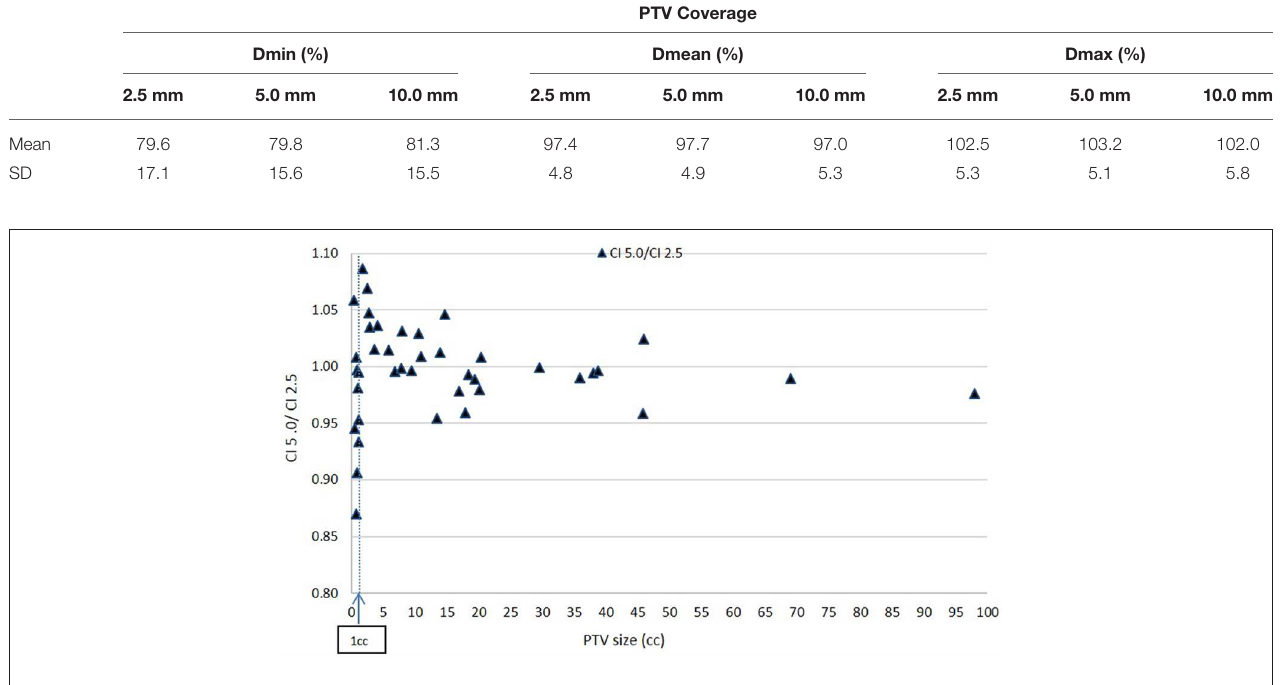
FIGURE 6 | Ratio of Conformity Indices CI 5.0 to CI 2.5 as a function of PTV size.